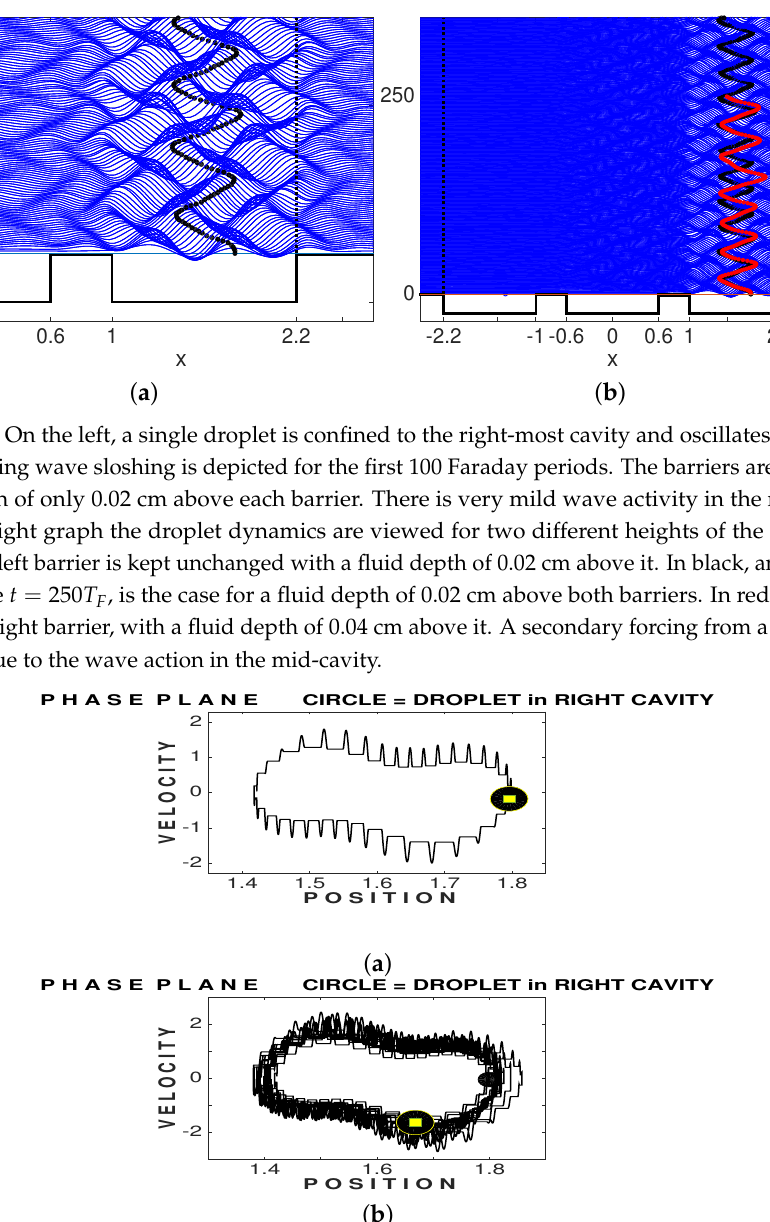
Figure 6. Phase plane dynamics for the simulation presented on the left of Figure 5. The black dot shows the droplet’s starting position, while the dot with an inner square indicates its final position. ( a ) At the top: A single cycle in phase space. Each spike represents the contact interval when the droplet is first accelerated by the underlying surface wave and then slowed down by surface friction. The spikes are separated by a Faraday period and their duration is T F /4. ( b ) At the bottom we observe the effectively periodic motion after many cycles, for a time interval of 500 T F